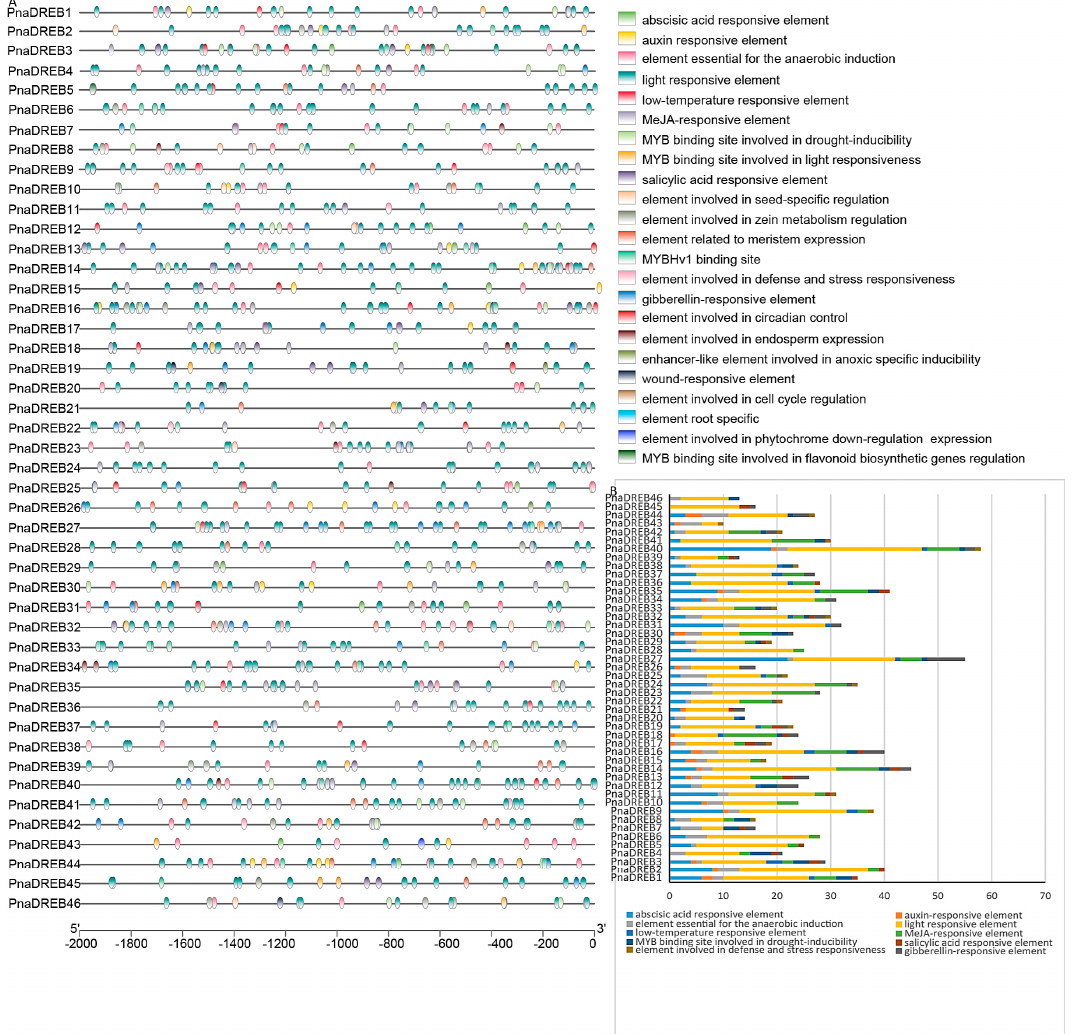
Figure 5. Cis -regulatory element predictive analyses of the PnaDREB promoter regions. Different colored boxes represent regulatory elements. ( A ) Phylogenetic tree with colored blocks of position and type of elements. ( B ) A bar chart displays the total number of elements identified and the number of each element in a specific